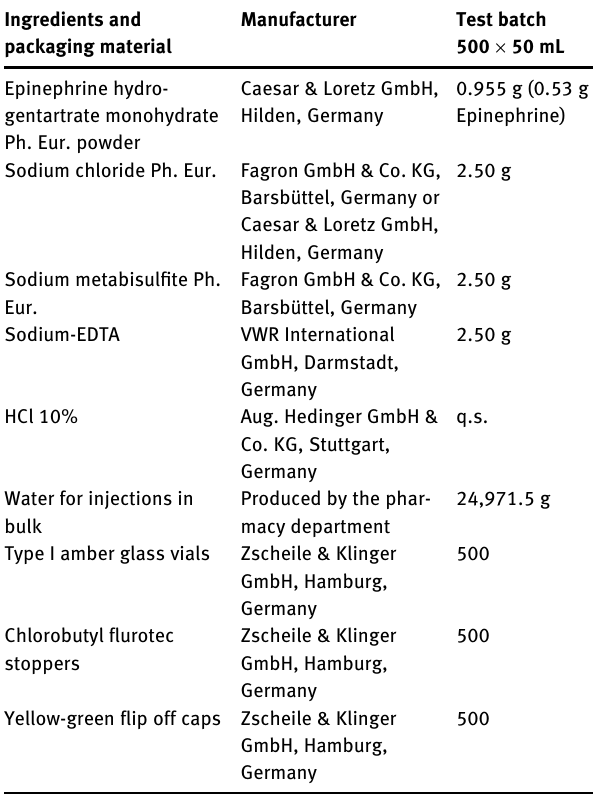
Table  : Formulation and packaging material E  .  mg/mL,  mL injection